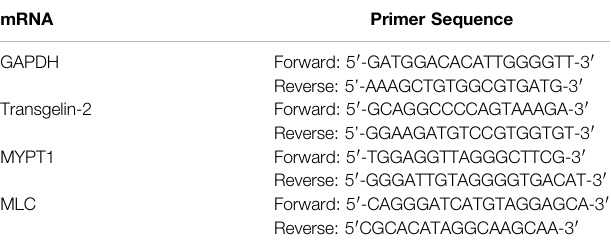
TABLE 1 | Primer sequences used in qRT-PCR